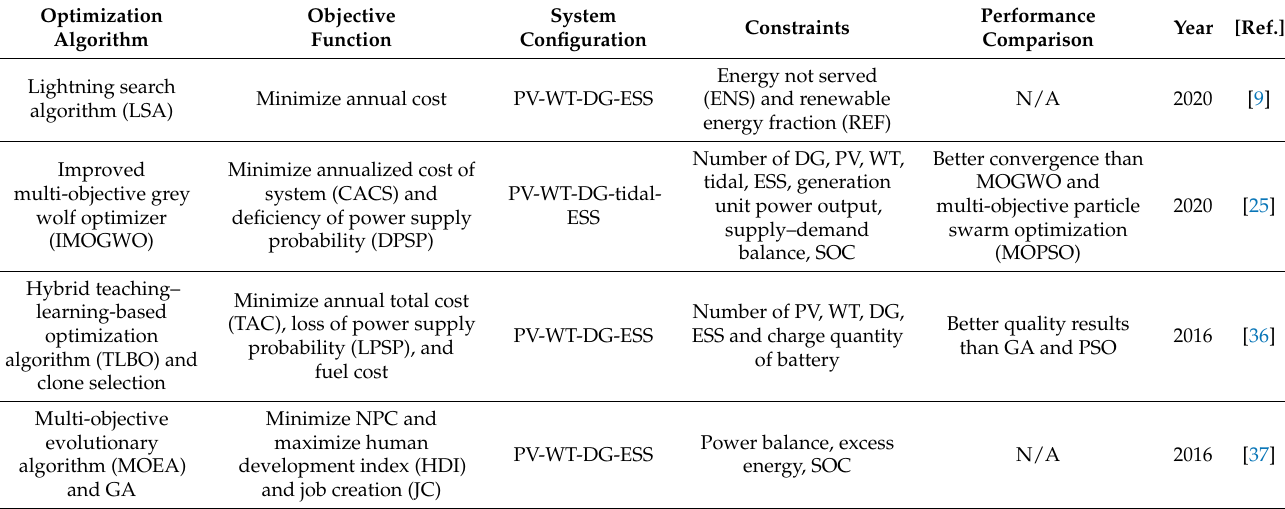
Table 2. Overview of hybrid optimization